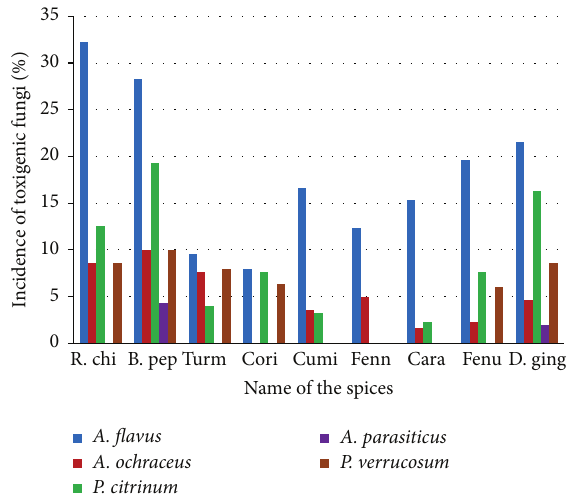
Figure 1: Percent incidence of toxigenic fungal contamination in spices